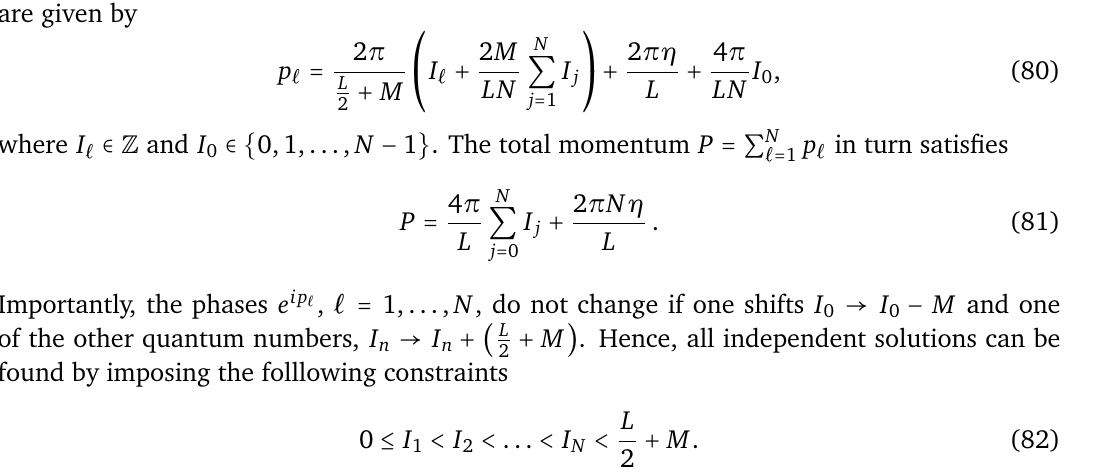
Figure 4: The range of the quantum numbers of the eigenstates of ˜ H configurations in a chain with L = 18 spins – cf. Eq. (90). The angular variable is 2 π gI 0 / N + π ( g − 1 ) mod 2 π ; the radius is proportional to the maximal value of I (cid:96) > that can be reached for given I 0 (each dashed circle corresponds to an integer 1 from L / 2 to L ). The arrow points at the circle representing the noninteracting sector. Symbols become larger and more transparent as the number of particles increases, whereas the colour represents the maximal I (cid:96) > configuration. The black dots identify points that are associated also with jammed configurations – the only ones in which, independently of I 0 , the maximal value of + M − I (cid:96) > is L 0 2